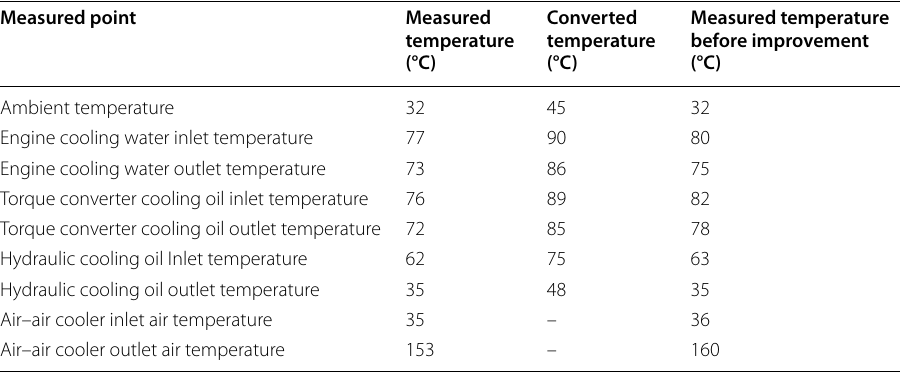
Table 3 Test results of full-speed driving conditions Measured